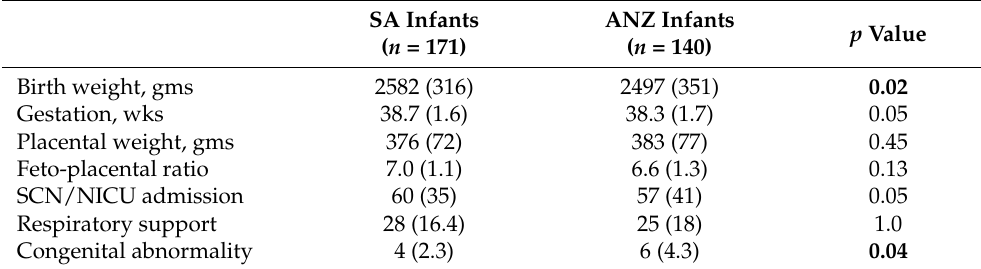
Table 3. Selected neonatal outcomes.